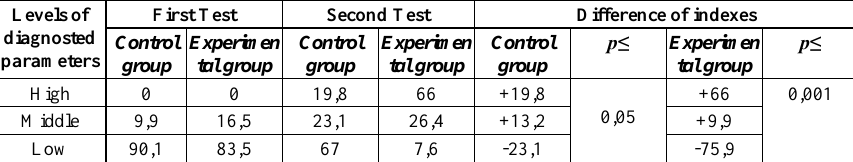
Table 4. “Marlins test” results taken on the second and third year of study